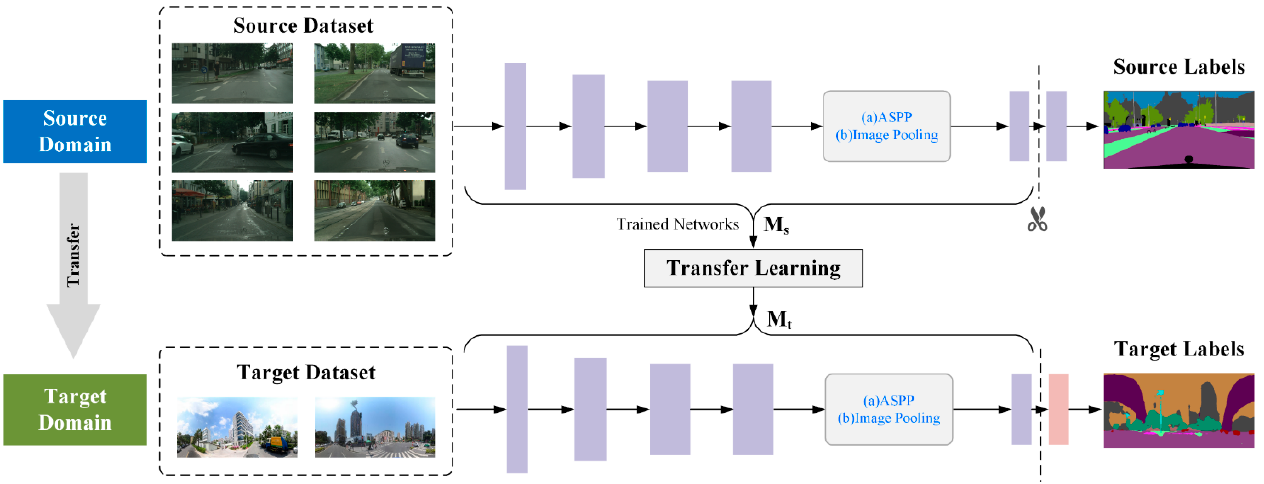
Figure 5. Framework of street view image segmentation.